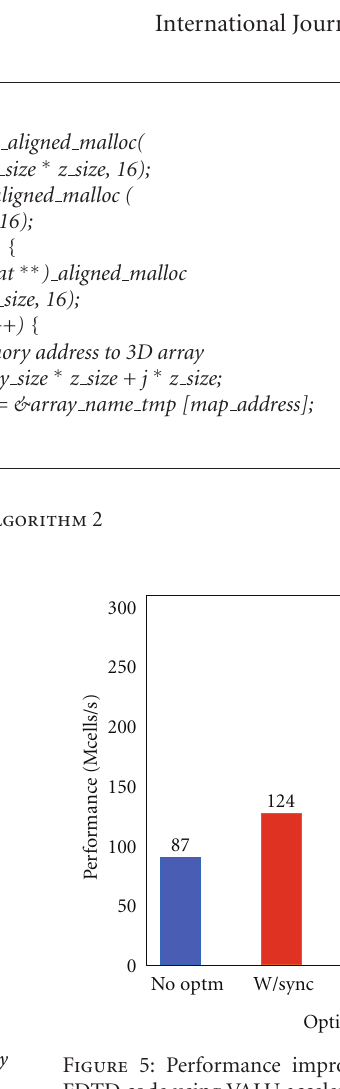
Figure 4: Data structure in the y - z plane.